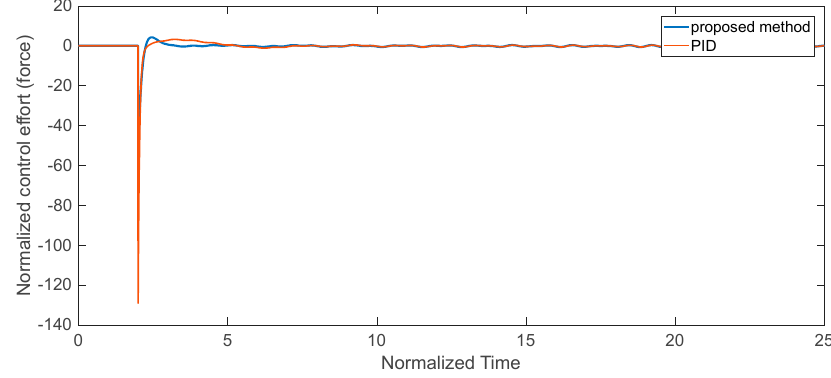
Figure 4. Control input based on the proposed method and PID.